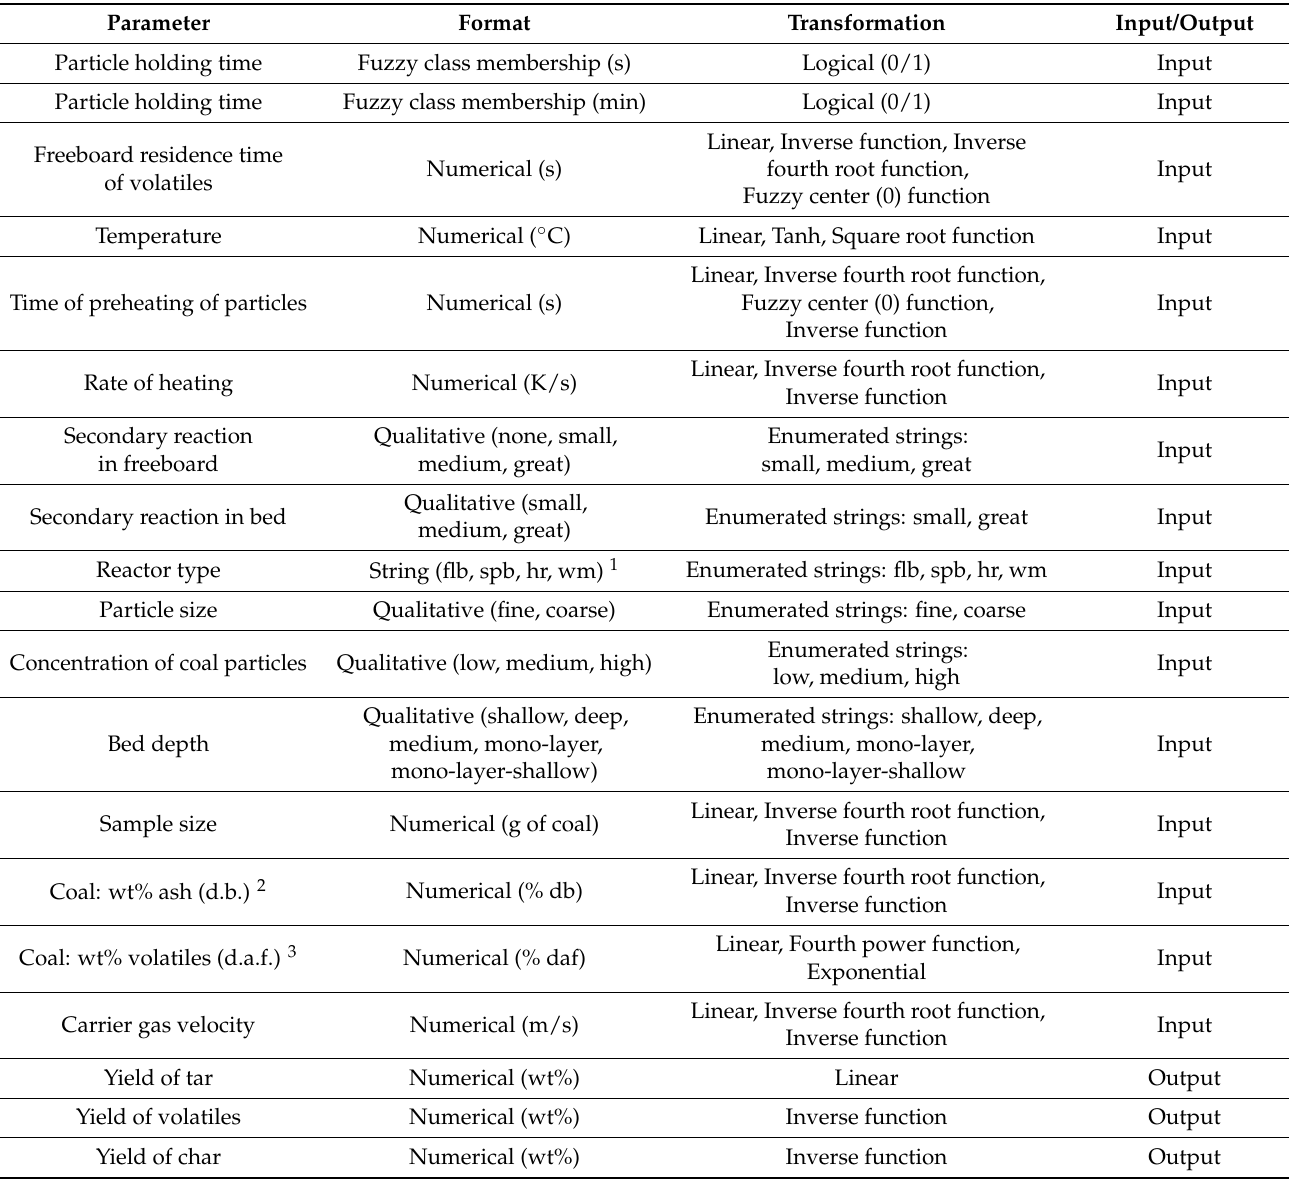
Table 1. The list of the parameters used to model the coal pyrolysis, and some details on their incorporation to ANN [67]. Reprinted with permission from